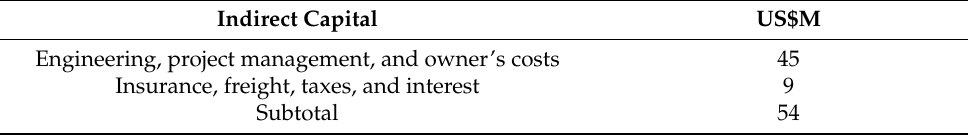
Table 5. CAPEX values (indirect capital) of the company Neometals. Source: [35].